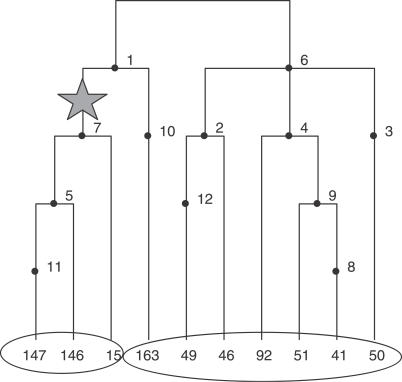
The Gene Tree Consistent with the Haplotypes in the Incidence Matrix of Table 6
Labels 1–12 refer to mutations S1–S12. At the bottom of each branch we report the multiplicity of each observed haplotype in the sample.